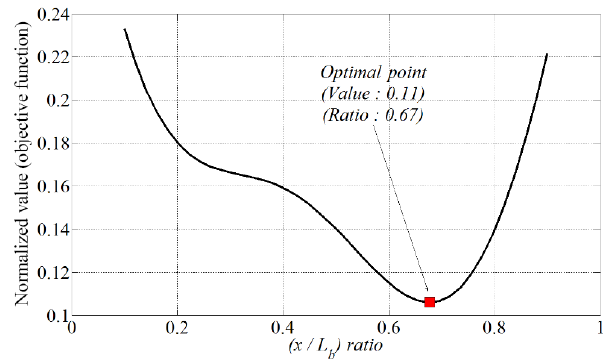
Figure 8. Variation of each state variable at inline 3-cylinder en- gine.